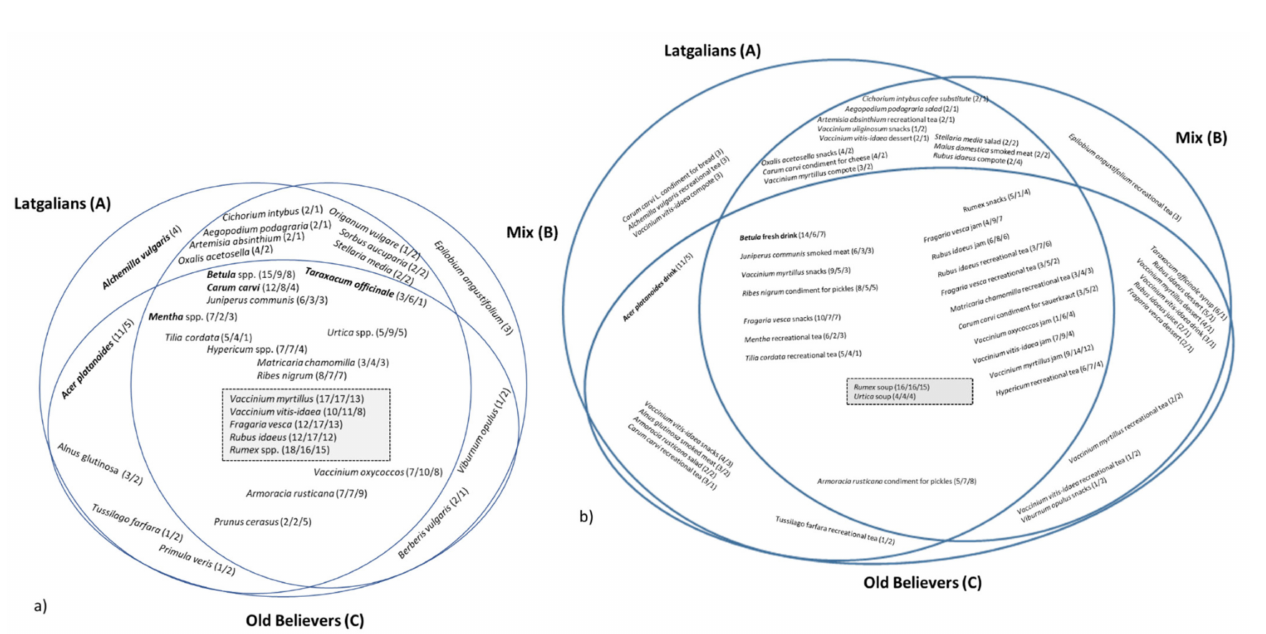
Figure 3. Taxa ( a ) and UIs ( b ) currently most used by the three different